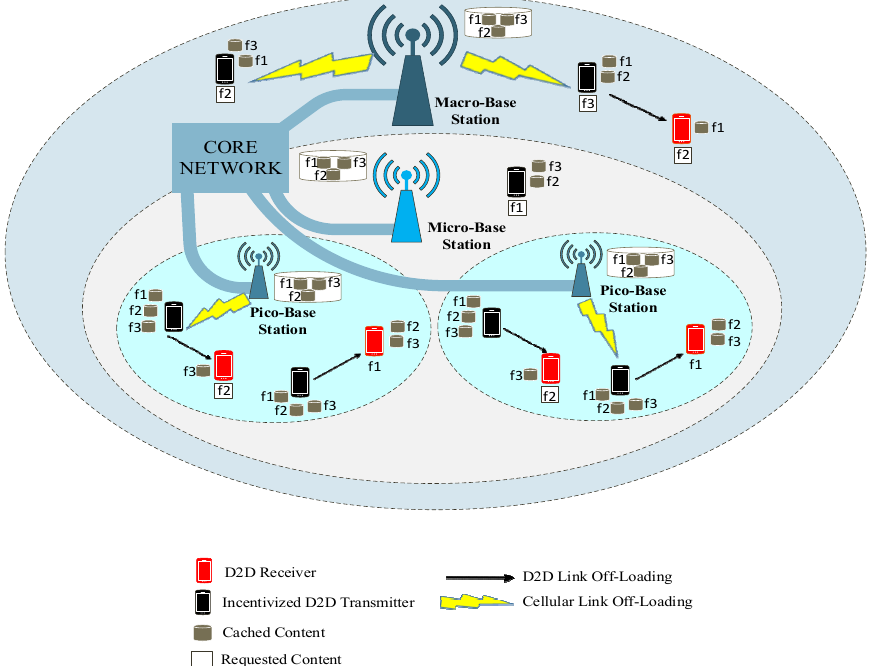
Figure 1. Cache-enabled D2D assisted multitier cellular network.